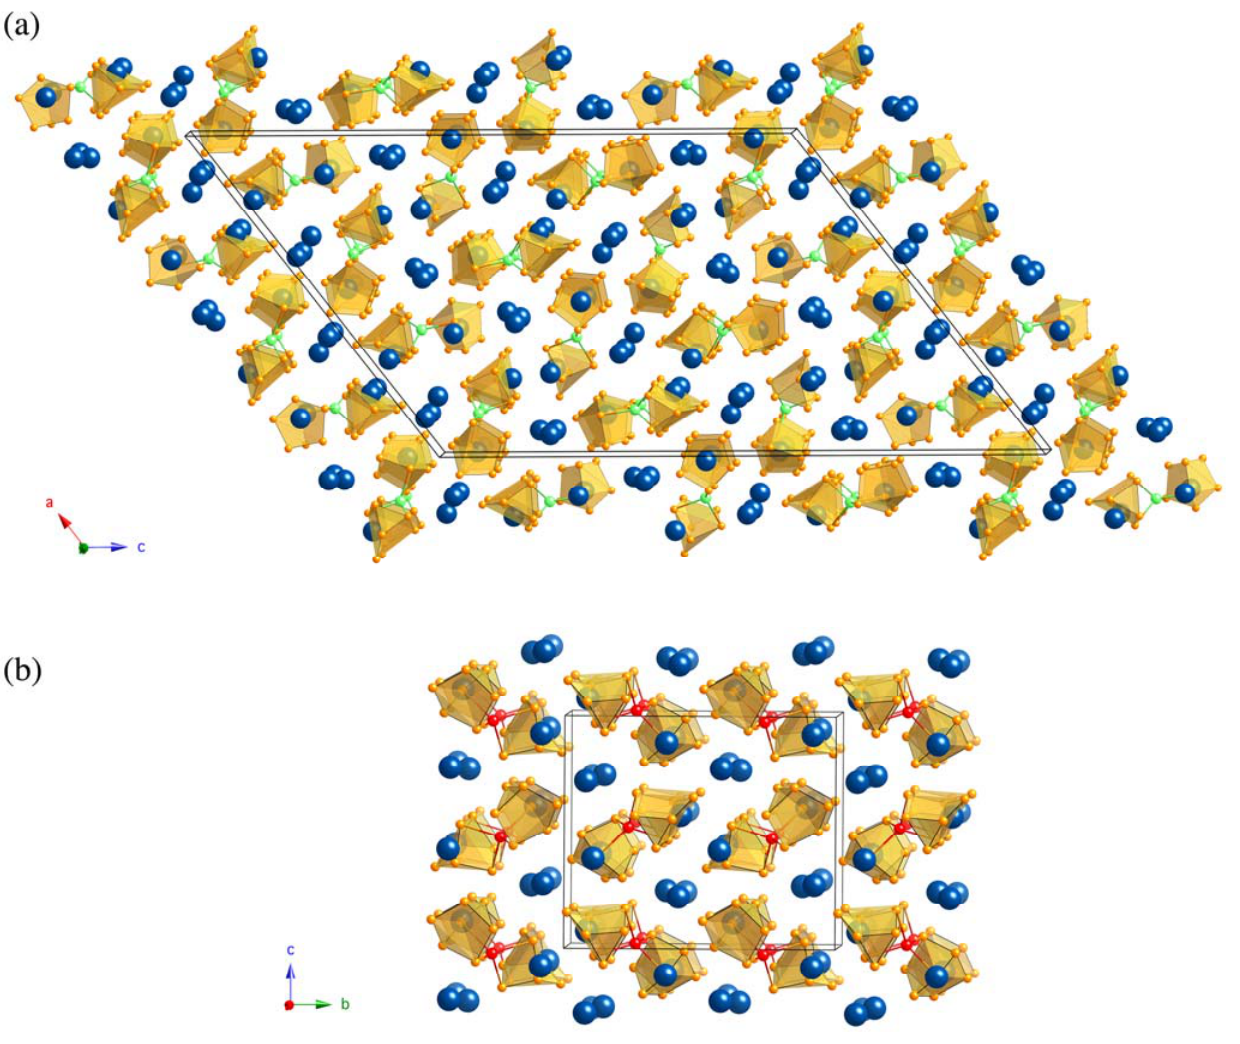
Figure 2. Schematic presentations of the crystal structures of (a) Cs CdAs . Color codes: As—orange; Cs—blue; Zn—light green; Cd—red. The (b) Cs 4 14 [As ] 3– clusters are depicted as translucent polyhedra, and the Zn–As and Cd–As bonds are 7 highlighted. Unit cells and projection directions are